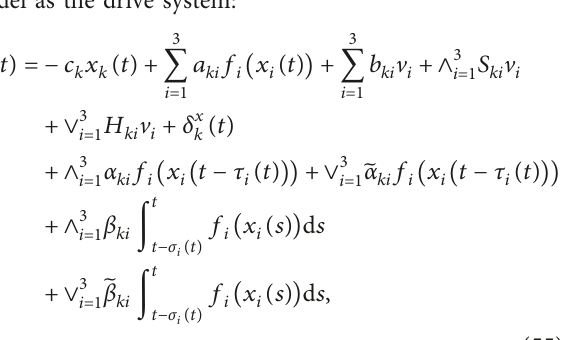
( t ) and y ( t ) for drive- 2 2